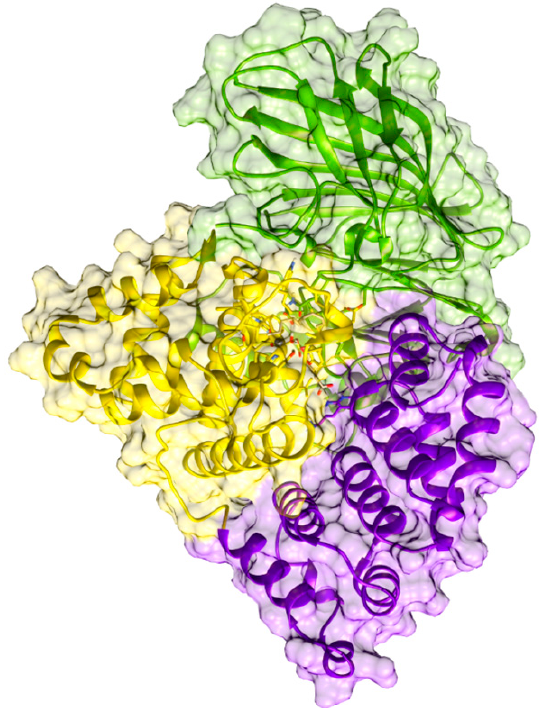
Figure 3. Complete view of the QM/MM-optimised LTA 4 :LTA 4 H Michaelis complex (the solvation waters are not shown for the sake of clarity). LTA 4 H has three domains that are pictured here in different colours: The N-terminal domain (in green), the catalytic domain (in yellow) and the C-terminal domain (in violet). The substrate LTA 4 is represented using a stick model.